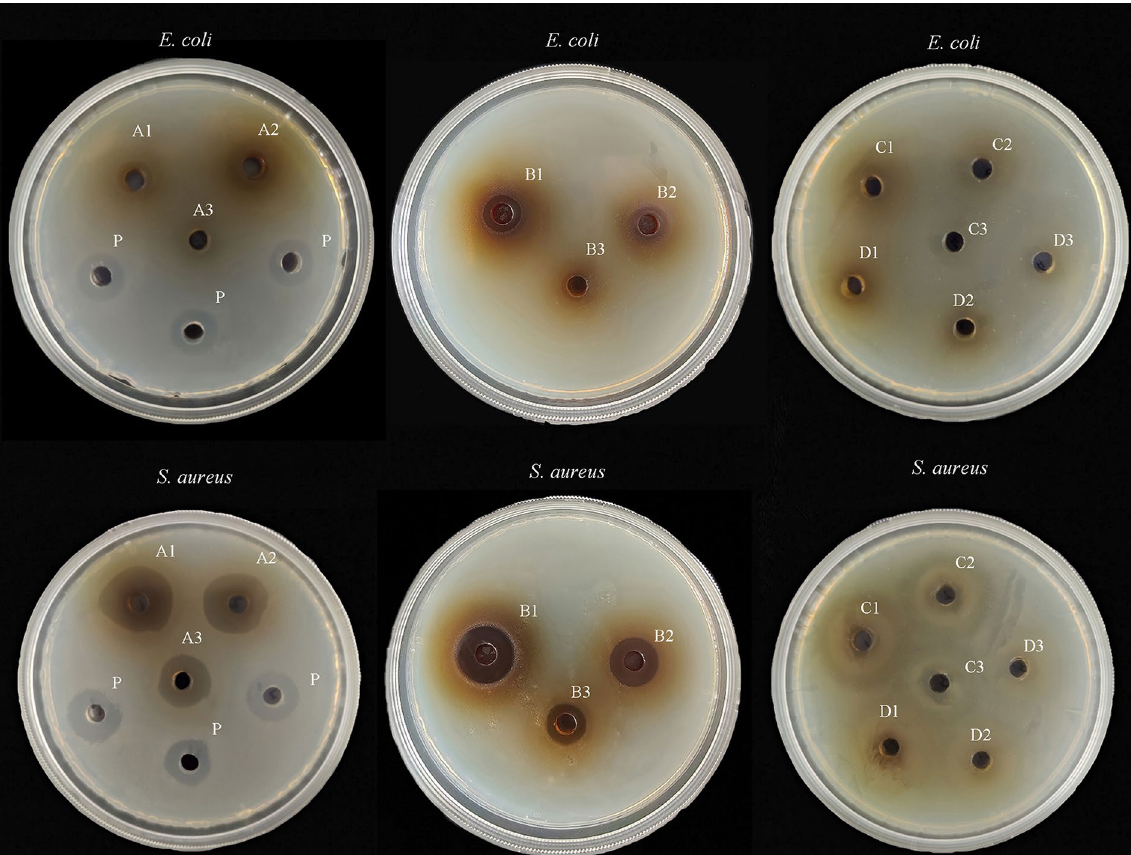
Fig. 4 Bacterial inhibition of E. coli and S. aureus (P, Positive control; A Water treat; B Hydrochloric acid buffer treat; C Phosphate buffer treat; D Artificial intestinal solution treat. 1, 2 g/mL; 2, 1 g/mL; 3, 0.5 g/mL)